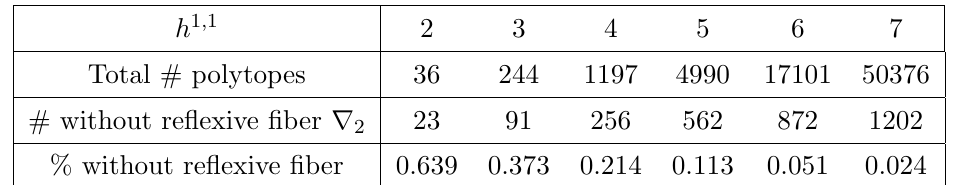
Table 7 . The numbers of polytopes without a 2D re(cid:13)exive (cid:12)ber, corresponding to Calabi-Yau threefolds without a manifest genus one (cid:12)bration, for small values of h 1 ; 1